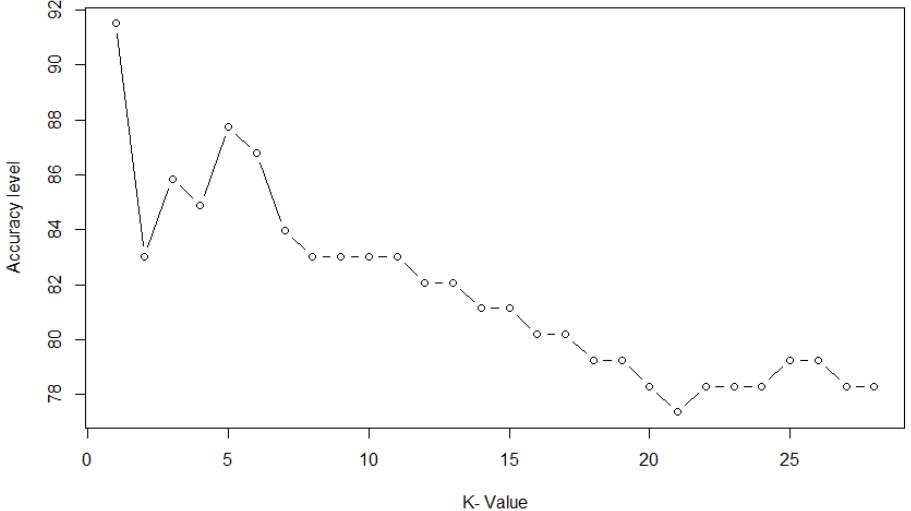
Figure 3. Selection of appropriate k value for KNN classification.